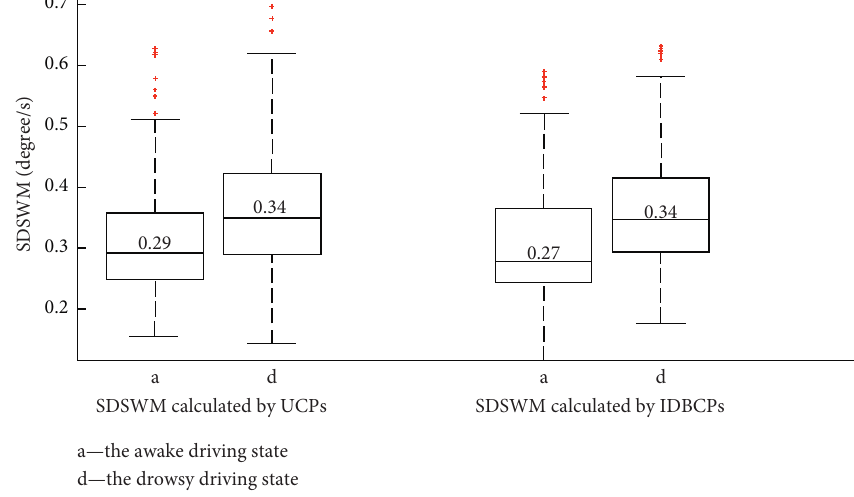
Figure 8: The boxplots of SDSWM calculated by UCPs and IDBCPs. Table 5: Results of drowsiness-detection across all participants.